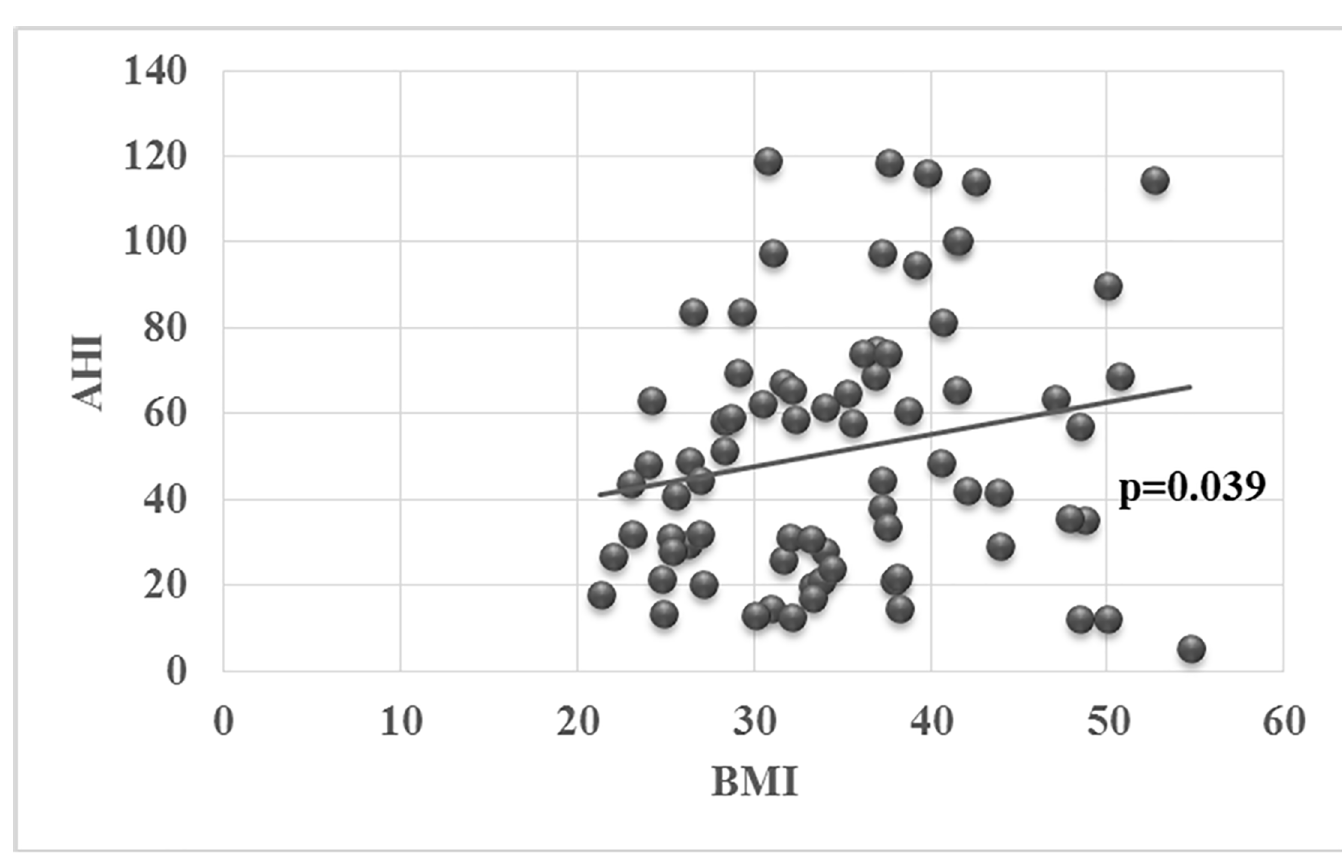
Fig 3. Correlation between BMI and AHI.